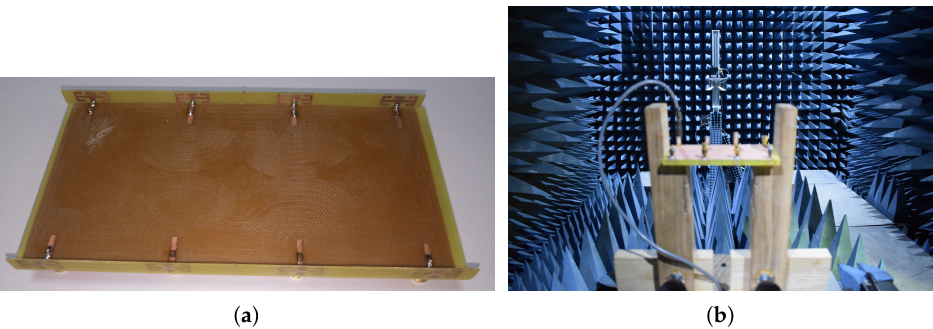
Figure 4. ( a ) Fabricated prototype front view, ( b ) far-field measurement set